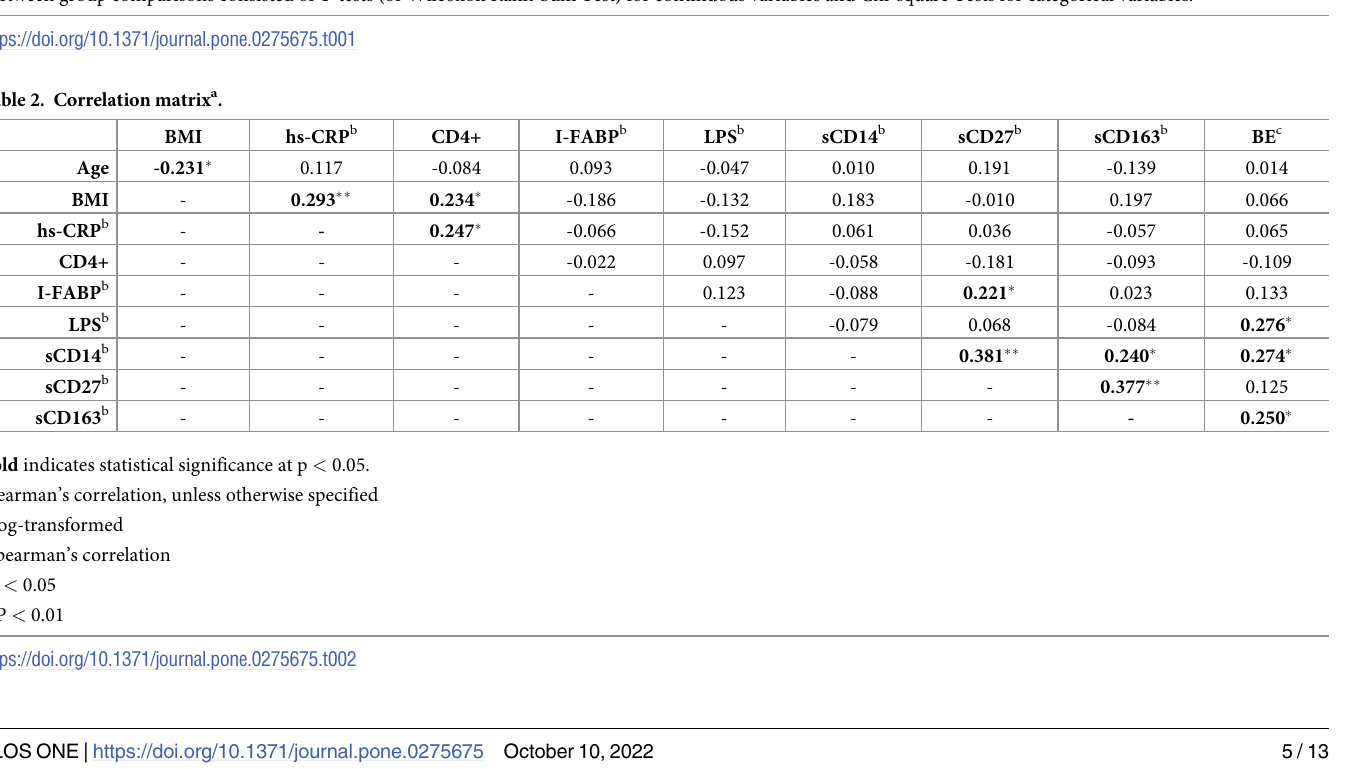
Bold indicates statistical significance at P < 0.05. a